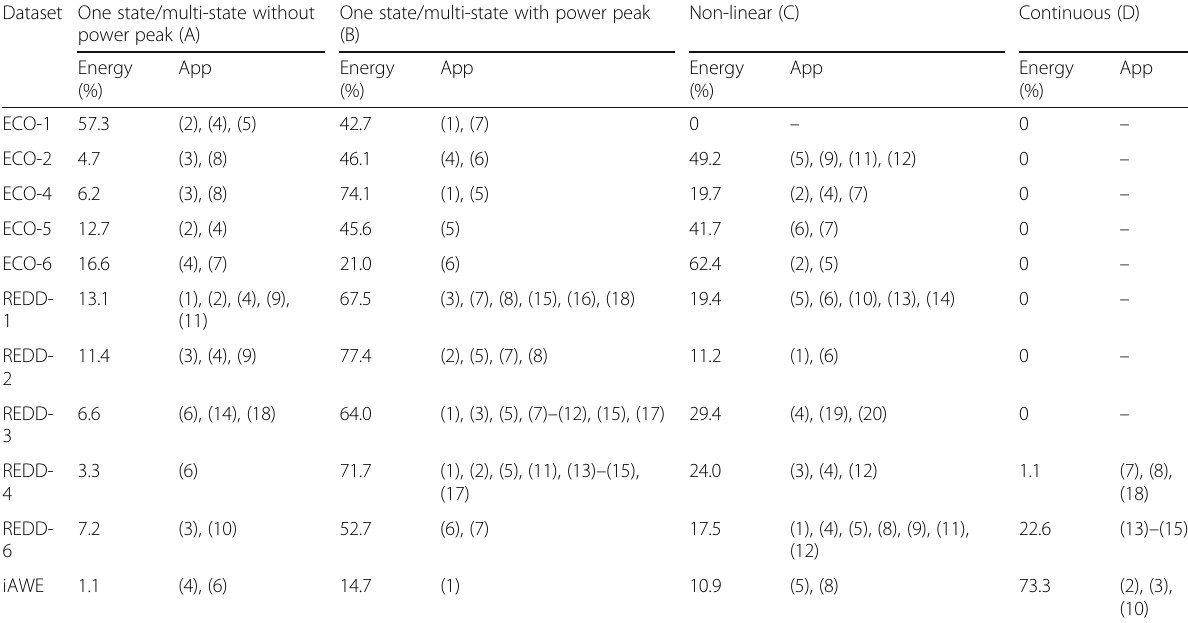
Dataset One state/multi-state without power peak (A)